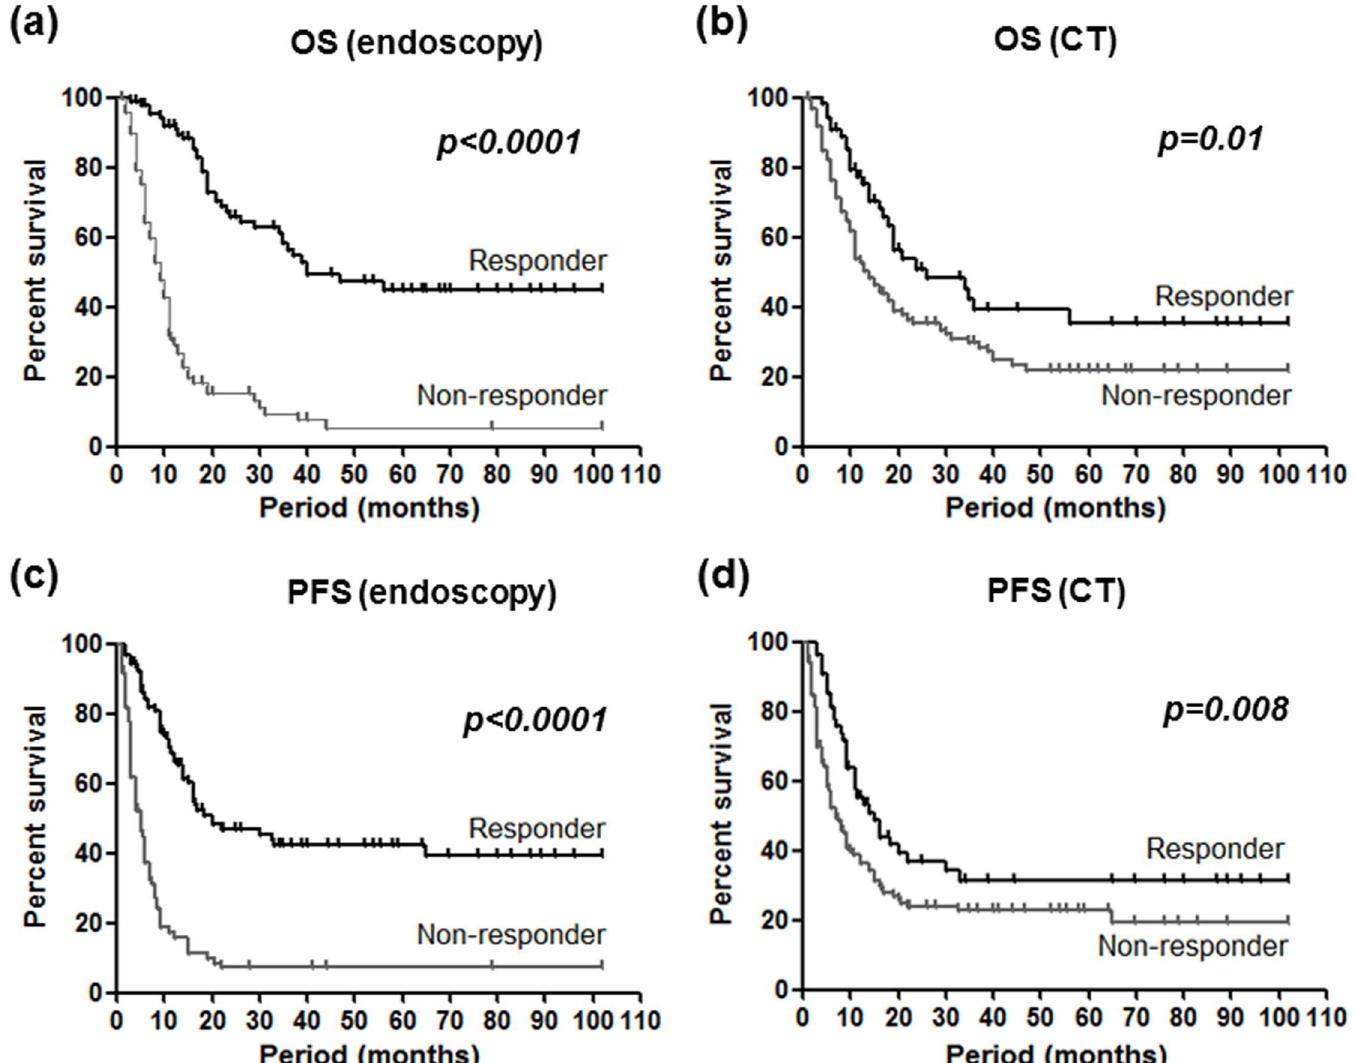
Fig 2. Overall survival (OS, upper) and progression-free survival (PFS, lower) and endoscopy (left) and CT (right) based response evaluations. Different two groups was assessedusing the Kaplan-Meier method and the Log rank test.